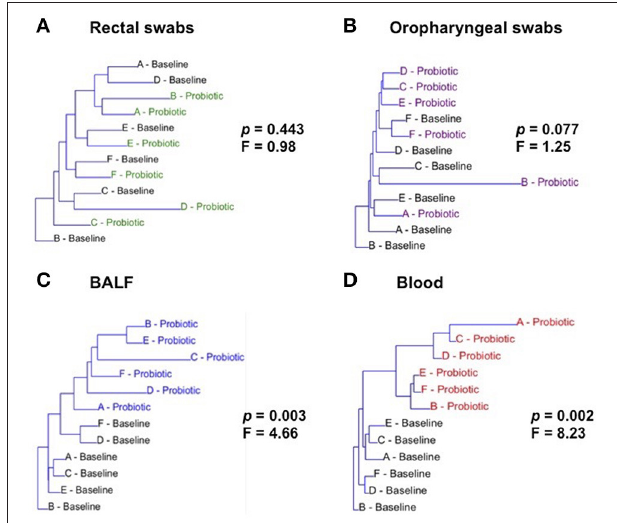
FIGURE 2 | Hierarchical clustering of samples at baseline and after treatment (Probiotic) for all sites: rectal swabs (A) , oropharyngeal swabs (OP) (B) , bronchoalveolar lavage fluid (BALF) (C) , and blood (D) . Letters A through F represent each of the cats. p and F values determined via one way PERMANOVA of Bray-Curtis